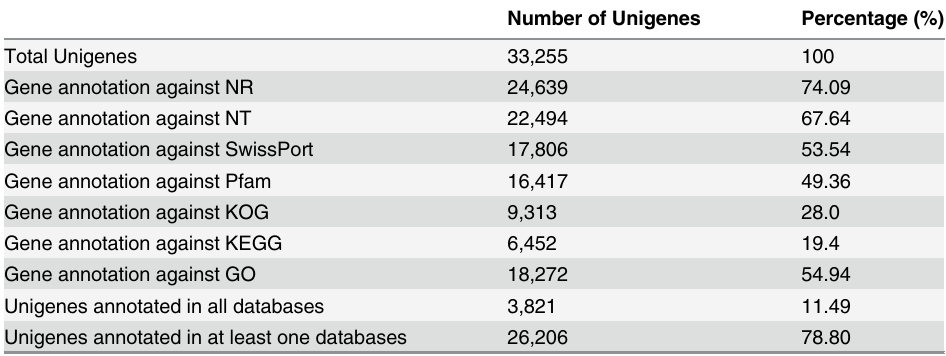
Table 3. Summary of unigene annotations against public